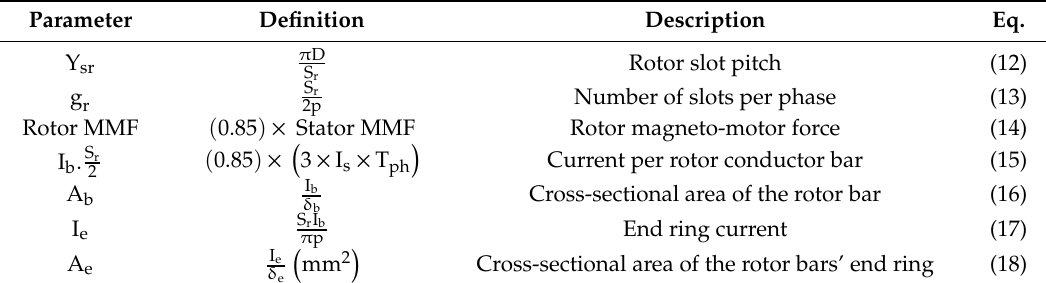
Table 3. Definition of the rotor parameters.